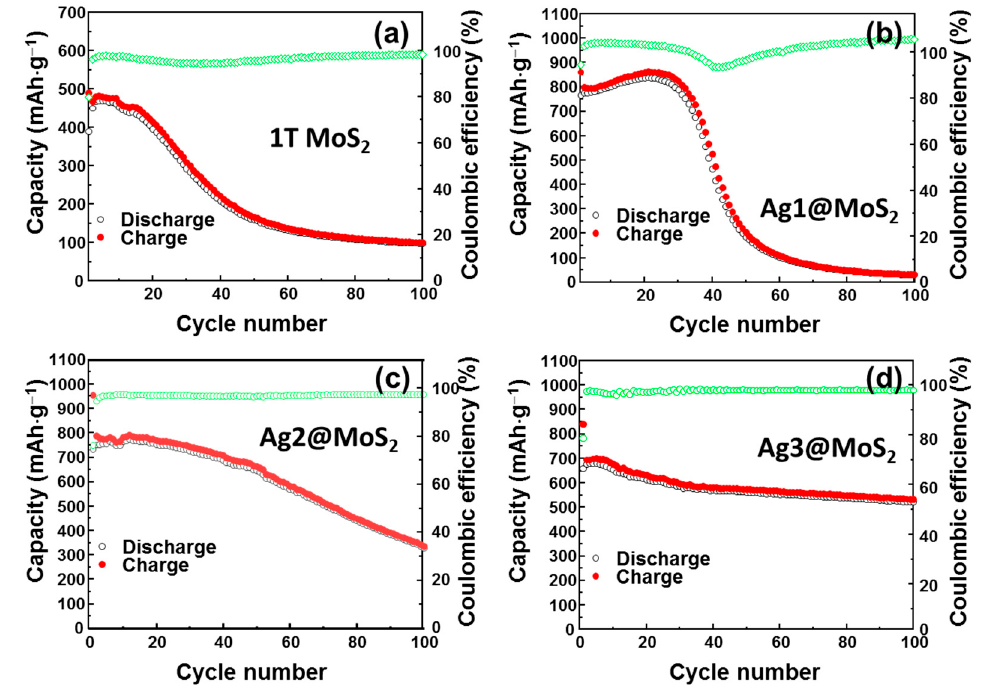
Figure 6. Cyclic performance of ( a ) MoS 2 NSs, ( b ) Ag1@MoS 2 , ( c ) Ag2@MoS 2 , and ( d ) Ag3@MoS 2 anodes.